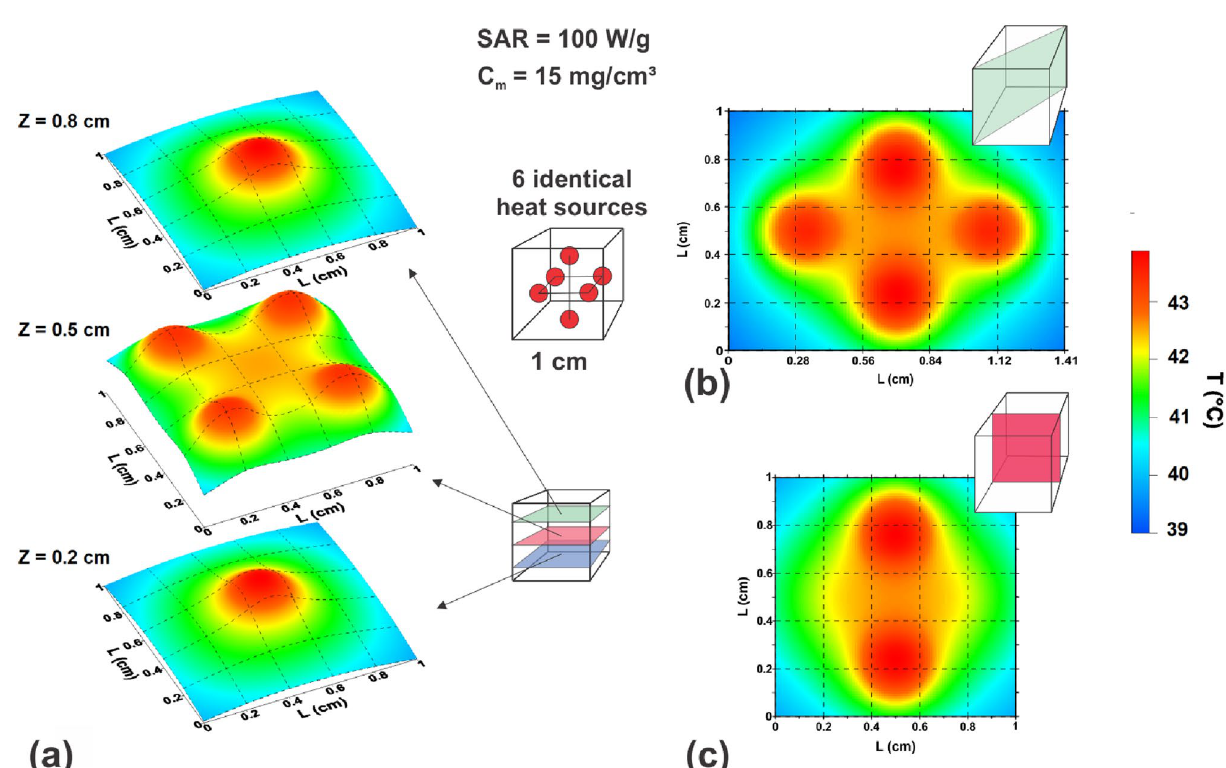
Figure 3. The spatial temperature distribution in biological media created by 6 heat sources of the same power symmetrically located with respect to cube center. ( a ) cross – sections of the cube by the planes z / L z = 0.2, 0.5 and 0.8, respectively; ( b , c ) the same for the planes ( x + y )/ L z = 1 and x / L z = 0.5,